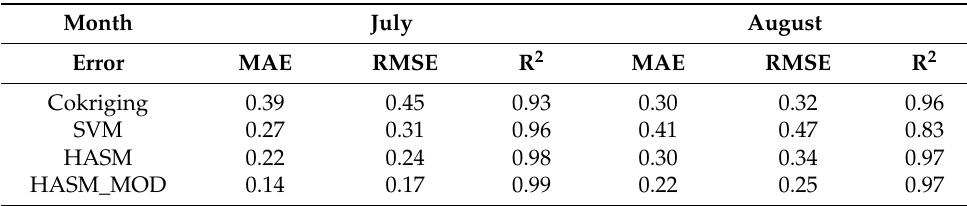
Table 1. Modeling evaluation indices using the cross-validation